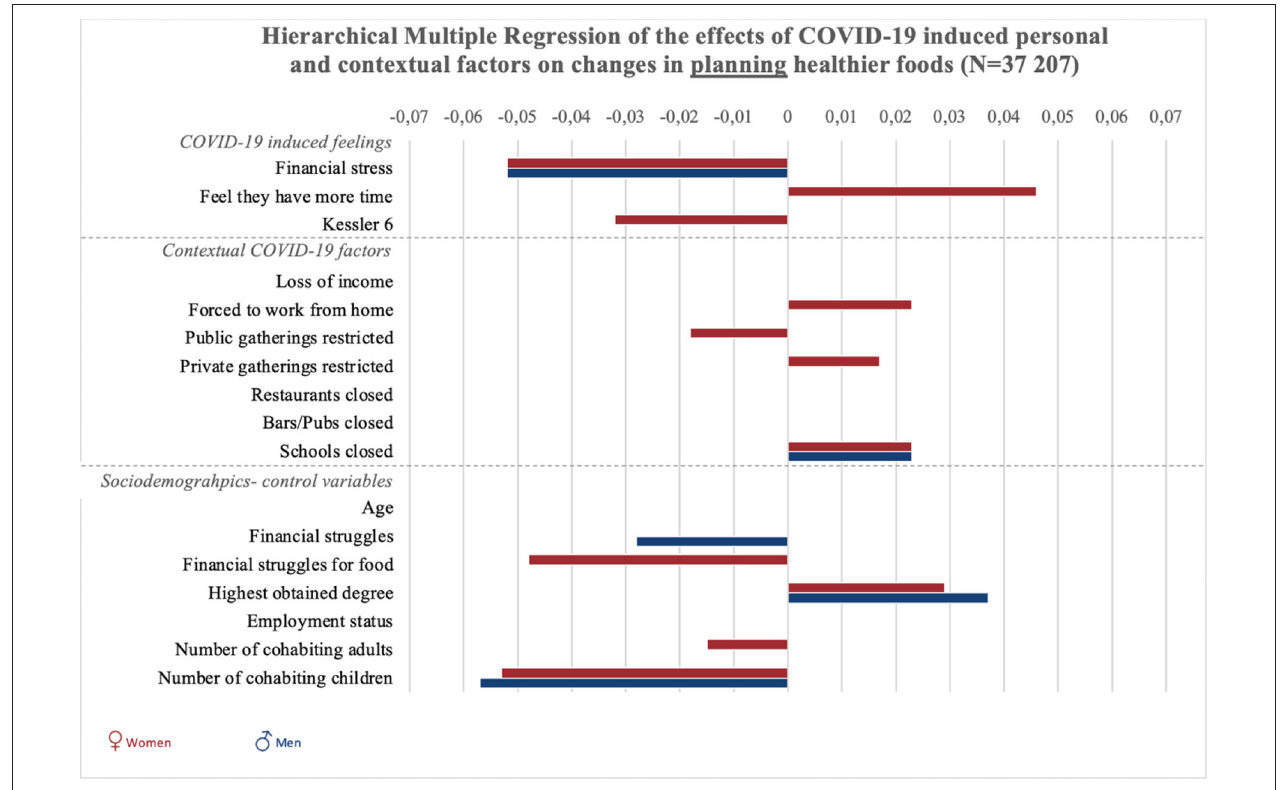
FIGURE 1 | Graphic summary of the significant relations between personal, contextual and sociodemographic variables and changes in planning healthier foods during COVID-19. We report beta-values only for significant relations in models 2 for planning healthier foods. Bars to the right indicate improvement in food planning, bars to the left indicate decreases in planning healthy